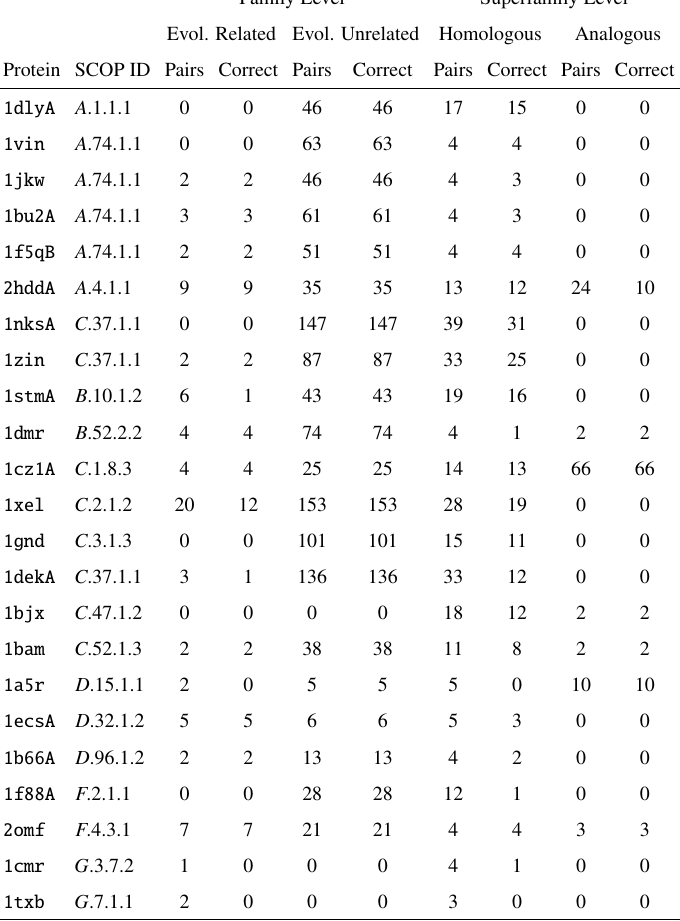
Table 5: Classification results for the 406 unseen protein pairs, for both data